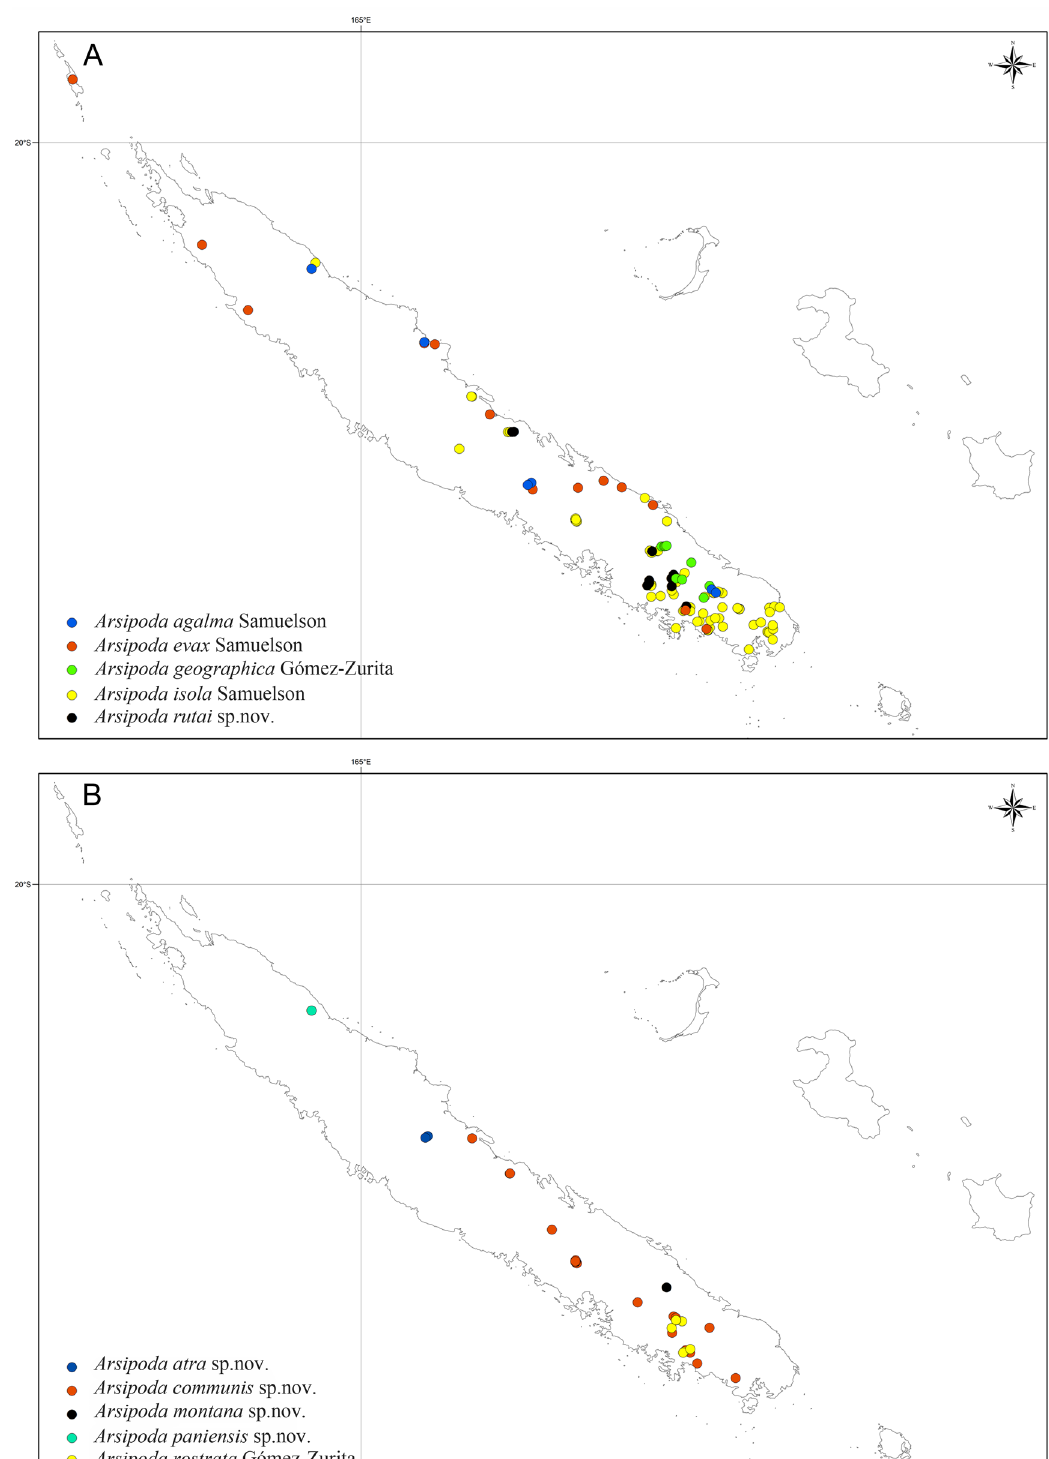
Fig. 14. Distributions of New Caledonian Arsipoda . A . Arsipoda agalma Samuelson, 1973, A.